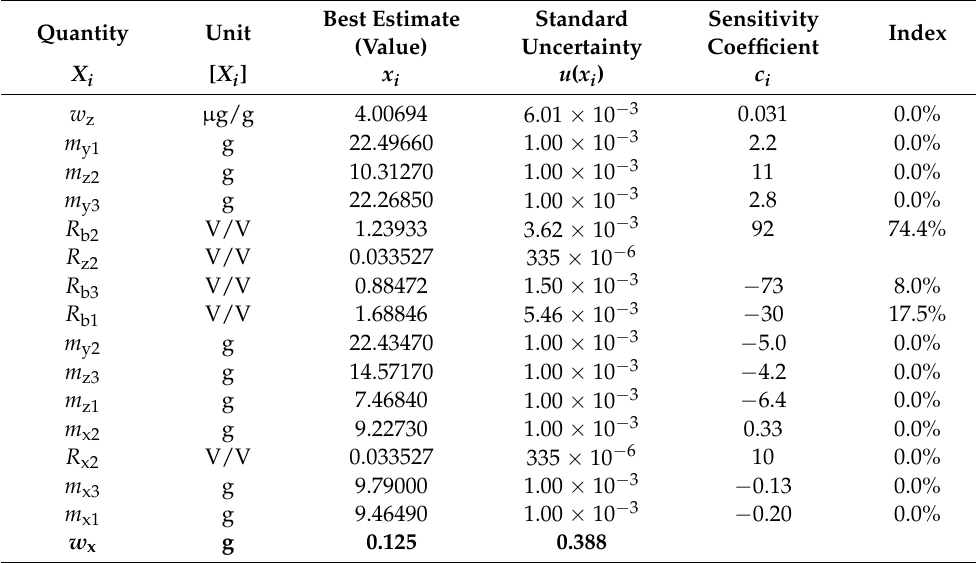
Table 8. A representative uncertainty budget of mass fraction w x (Si) determined using the approach of [1] (using the blends b 2 , b 3 , b 4 ). The main contributions originate from R b2 , R b1 , and R b3 , with the largest absolute values of respective sensitivity coefficients.